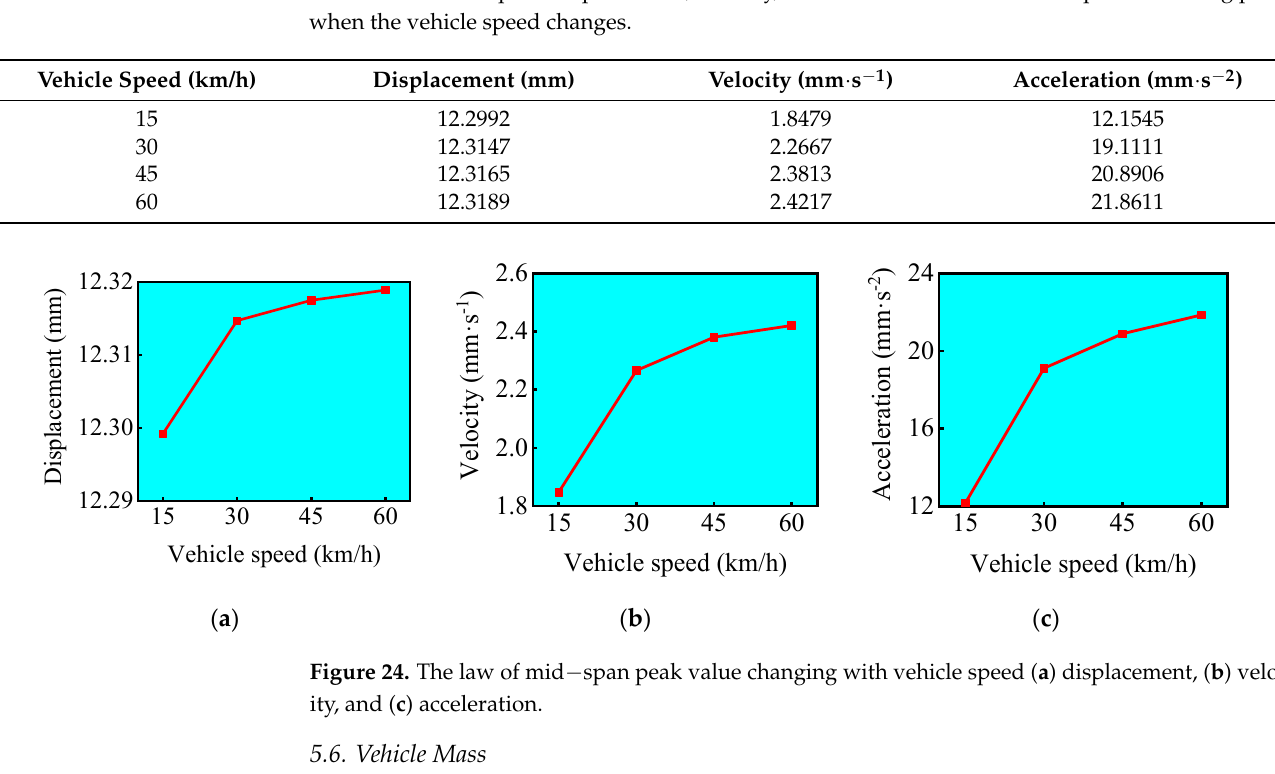
Figure 23. Peak value variation rule of different measuring points when the vehicle speed changes ( a ) displacement, ( b ) velocity, and ( c ) acceleration. Table 7. Results of peak displacement, velocity, and acceleration at the mid − span measuring point when the vehicle speed changes.